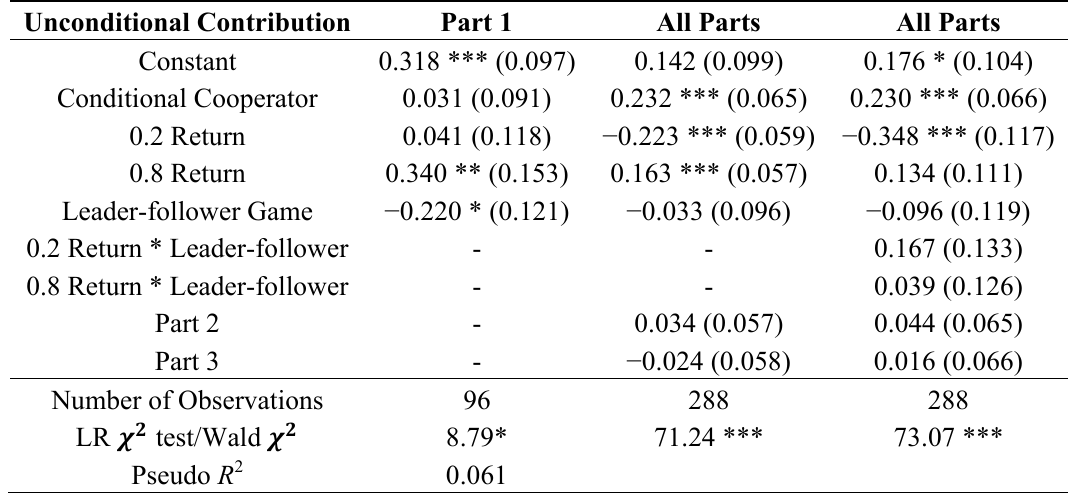
Table 7. The results of Tobit regressions with unconditional contribution as a proportion of total endowment as the dependent variable. A panel regression is used for all